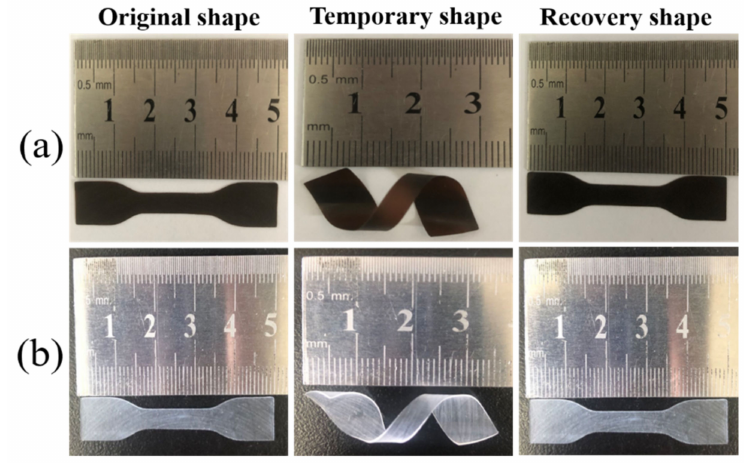
Figure 14. The shape-memory behavior of PWPU 5000 ( a ) and BWPU 5000 ( b ). Photos with original shape, temporary shape (deformed at 25 ◦ C for 20 min and fixed at 0 ◦ C for 20 min) and recovered state after being soaked in 70 ◦ C water.